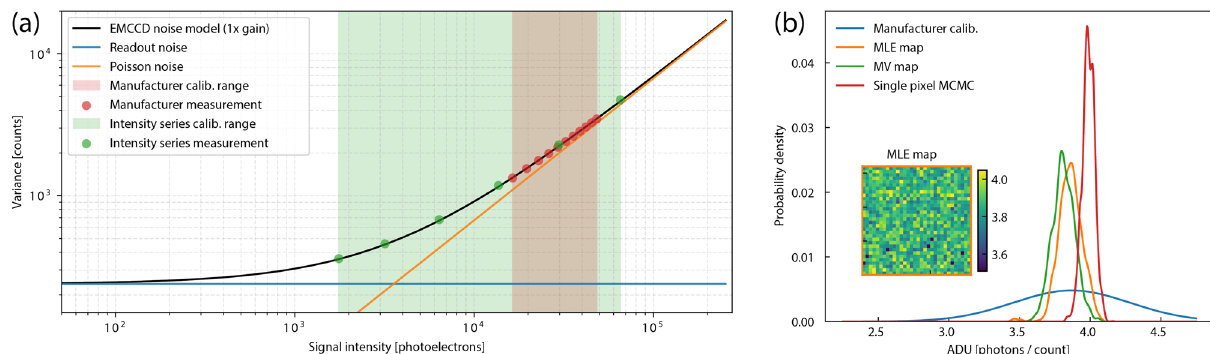
Figure 2. ADU calibration. ( a ) The photon transfer function for ADU calibration. Readout noise (blue) is independent of signal intensity while Poisson noise (orange) is linearly proportional to the signal intensity. The manufacturer calibration range encompassed a small range of the signal intensity and was linearly spaced, which weighs the data from high signal intensities more heavily. Calibration measurements for this work (green) spanned a broader range and were logarithmically distributed. ( b ) Distributions of ADU estimates determined using the MLE method on each pixel (orange), the MV test on each pixel (green), and the manufacturer calibration data (blue). MCMC inference on a single pixel (red), shows the uncertainty associated with an individual measurement. The inset MLE map emphasizes the calibrated ADU values are uniform across the sensor area despite pixel-wise variations in the photon flux (image patterns due to the